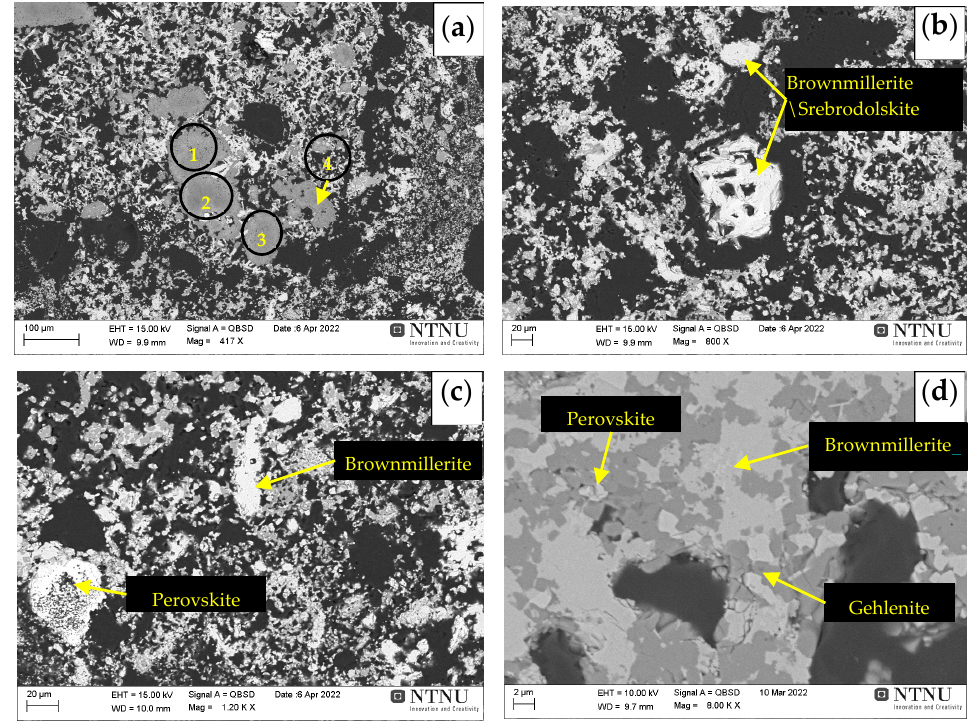
Figure 11. SEM images of C 1.15 A-1150 °C ( a – c ) and C 0.85 A-1150 °C ( d ), and the identified phases.